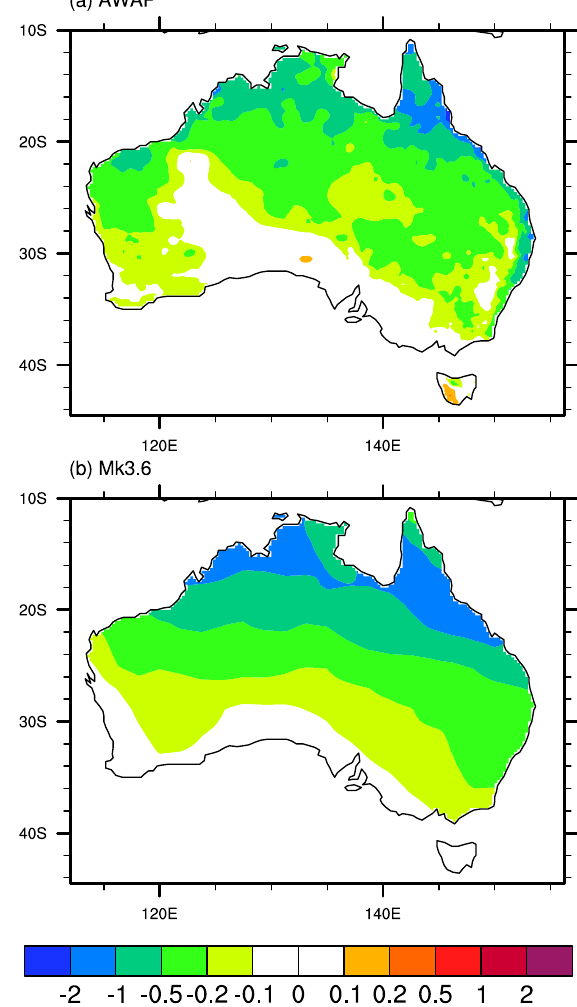
Fig. 9. DJFM rainfall regressed against Ni˜no-3.4 SST (mmday − 1 K − 1 ) for the period 1951–2010, from (a) obser- vations (AWAP and HadISST), and (b) the HIST ensemble. All data sets were linearly detrended before performing the regression. The model output was interpolated to the finer (0.25 ◦ ) AWAP grid prior to